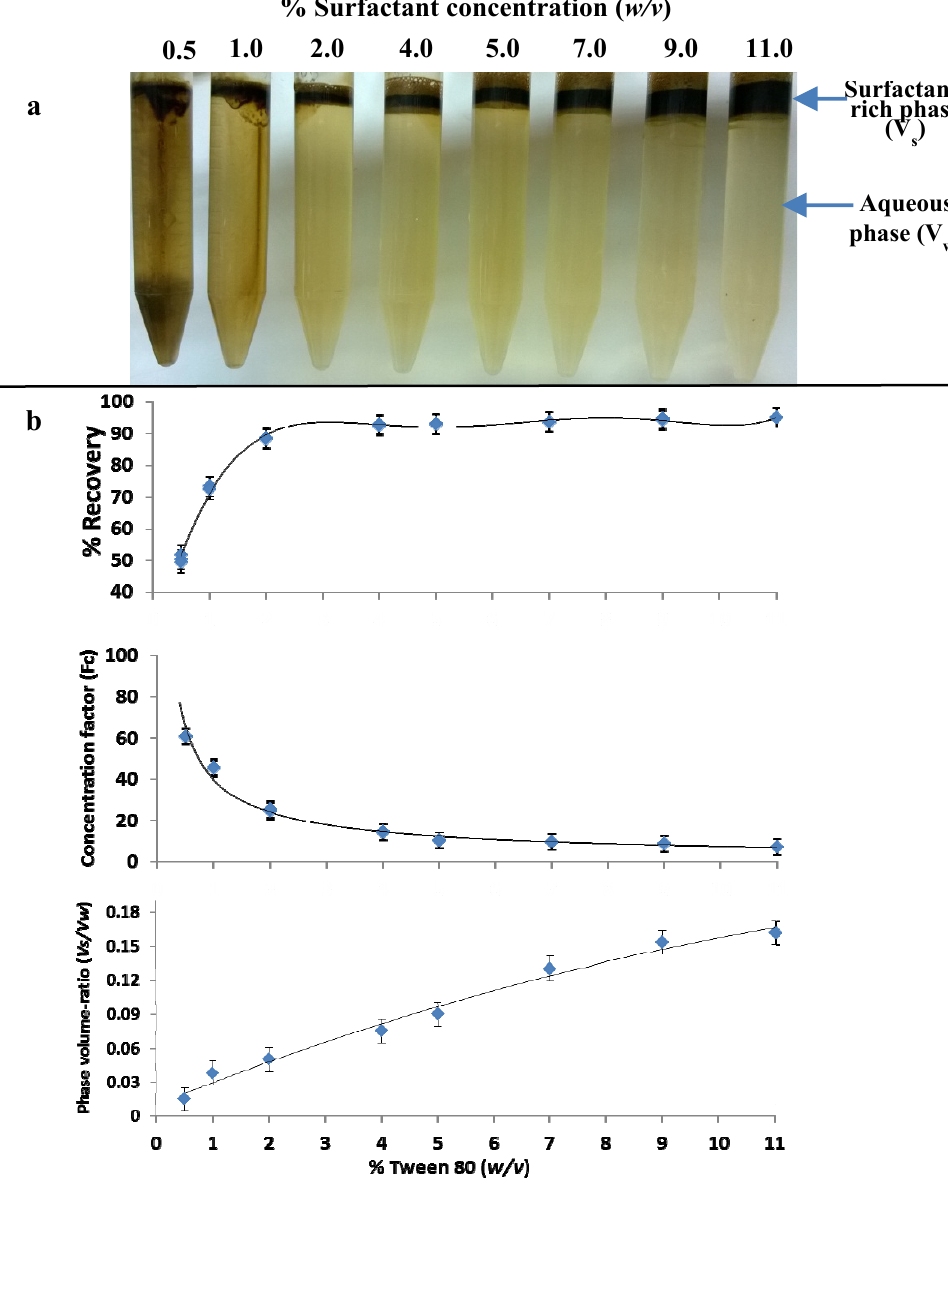
Figure 3. The influence of the added Tween 80 quantity in the performance of salting-out cloud point extraction (CPE). ( a ) Photographs of the phase separations and ( b ) the percent of recovery efficiency, concentration factor (F salting-out-assisted CPE of polyphenols from olive leaf extract (2500 ppm). The amount of SO added to olive leaf extract was 35% (w/v); pH: 2.6; settling time: 5 min; liquid Na 2 4 temperature: 25